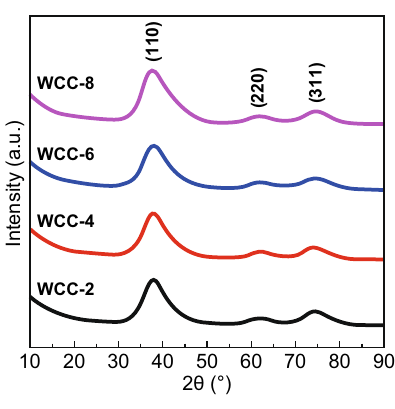
Fig. 2 XRD patterns of different tungsten carbide/carbon composites